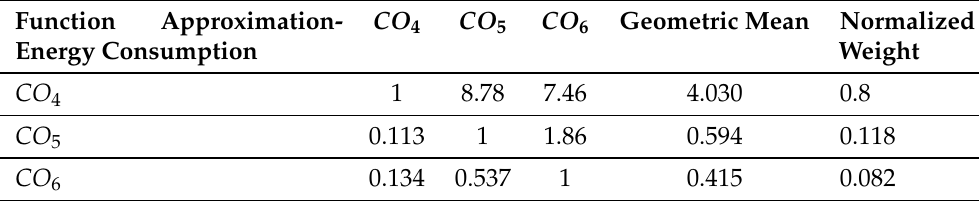
Table 12. Comparison between suitable components for function approximation with respect to energy consumption.